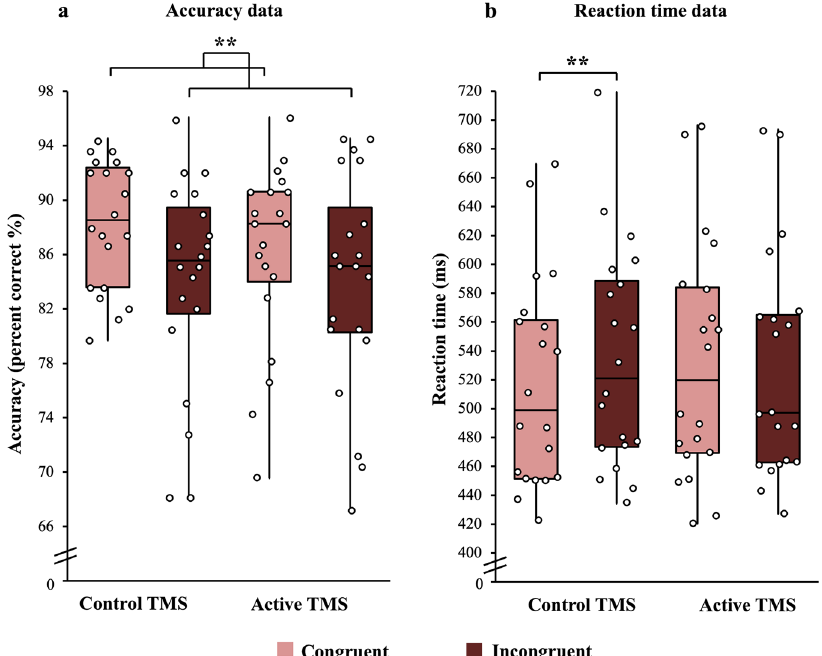
Fig. 3 The effect of TMS on accuracy and reaction time data. Box plot summary of accuracy ( a ) and reaction time ( b ) data depicting the minimum and maximum values, the lower and upper quartiles and the median scores. Individual data points are indicated by open circles. Lighter-coloured bars depict congruent trials, and darker-coloured bars depict incongruent trials. Accuracy data ( a ) showed a main effect of congruency (no interaction). RT data ( b , correct trials only) revealed that participants were faster in congruent trials than incongruent trials under the Control TMS condition but showed no evidence of a congruency effect under Active TMS (signi fi cant interaction). ** P < 0.01. N = 20